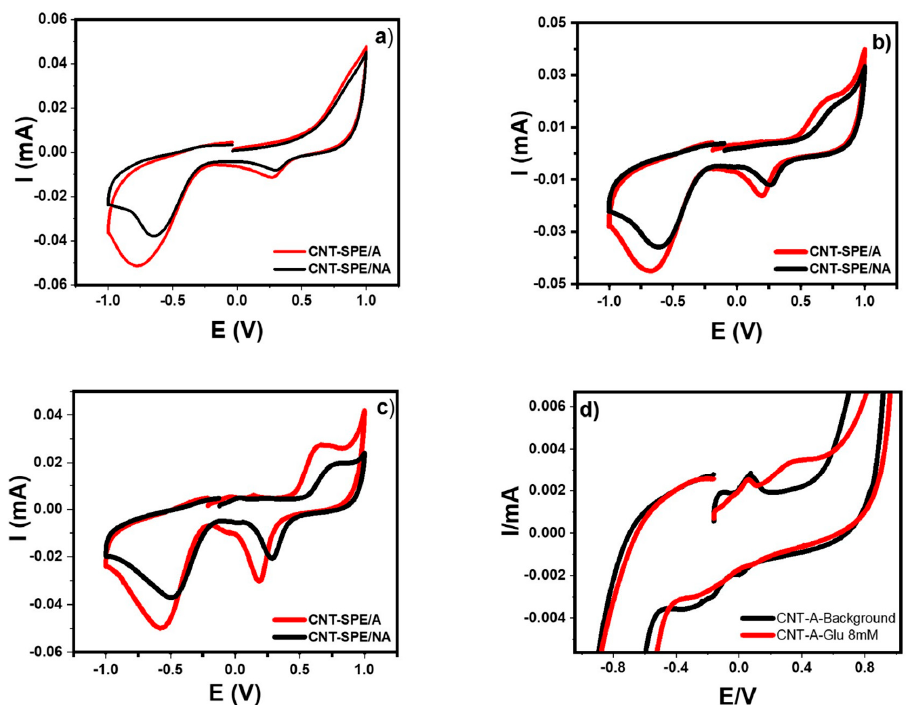
Figure 8. Cyclic voltammetry of ( a ) Sorensen buffer pH7, ( b ) Glucose 8 mM, ( c ) Glucose 4 mM on CNT-SPE electrochemically activated (CNT-SPE/A) and without activation (CNT-SPE/NA), and ( d